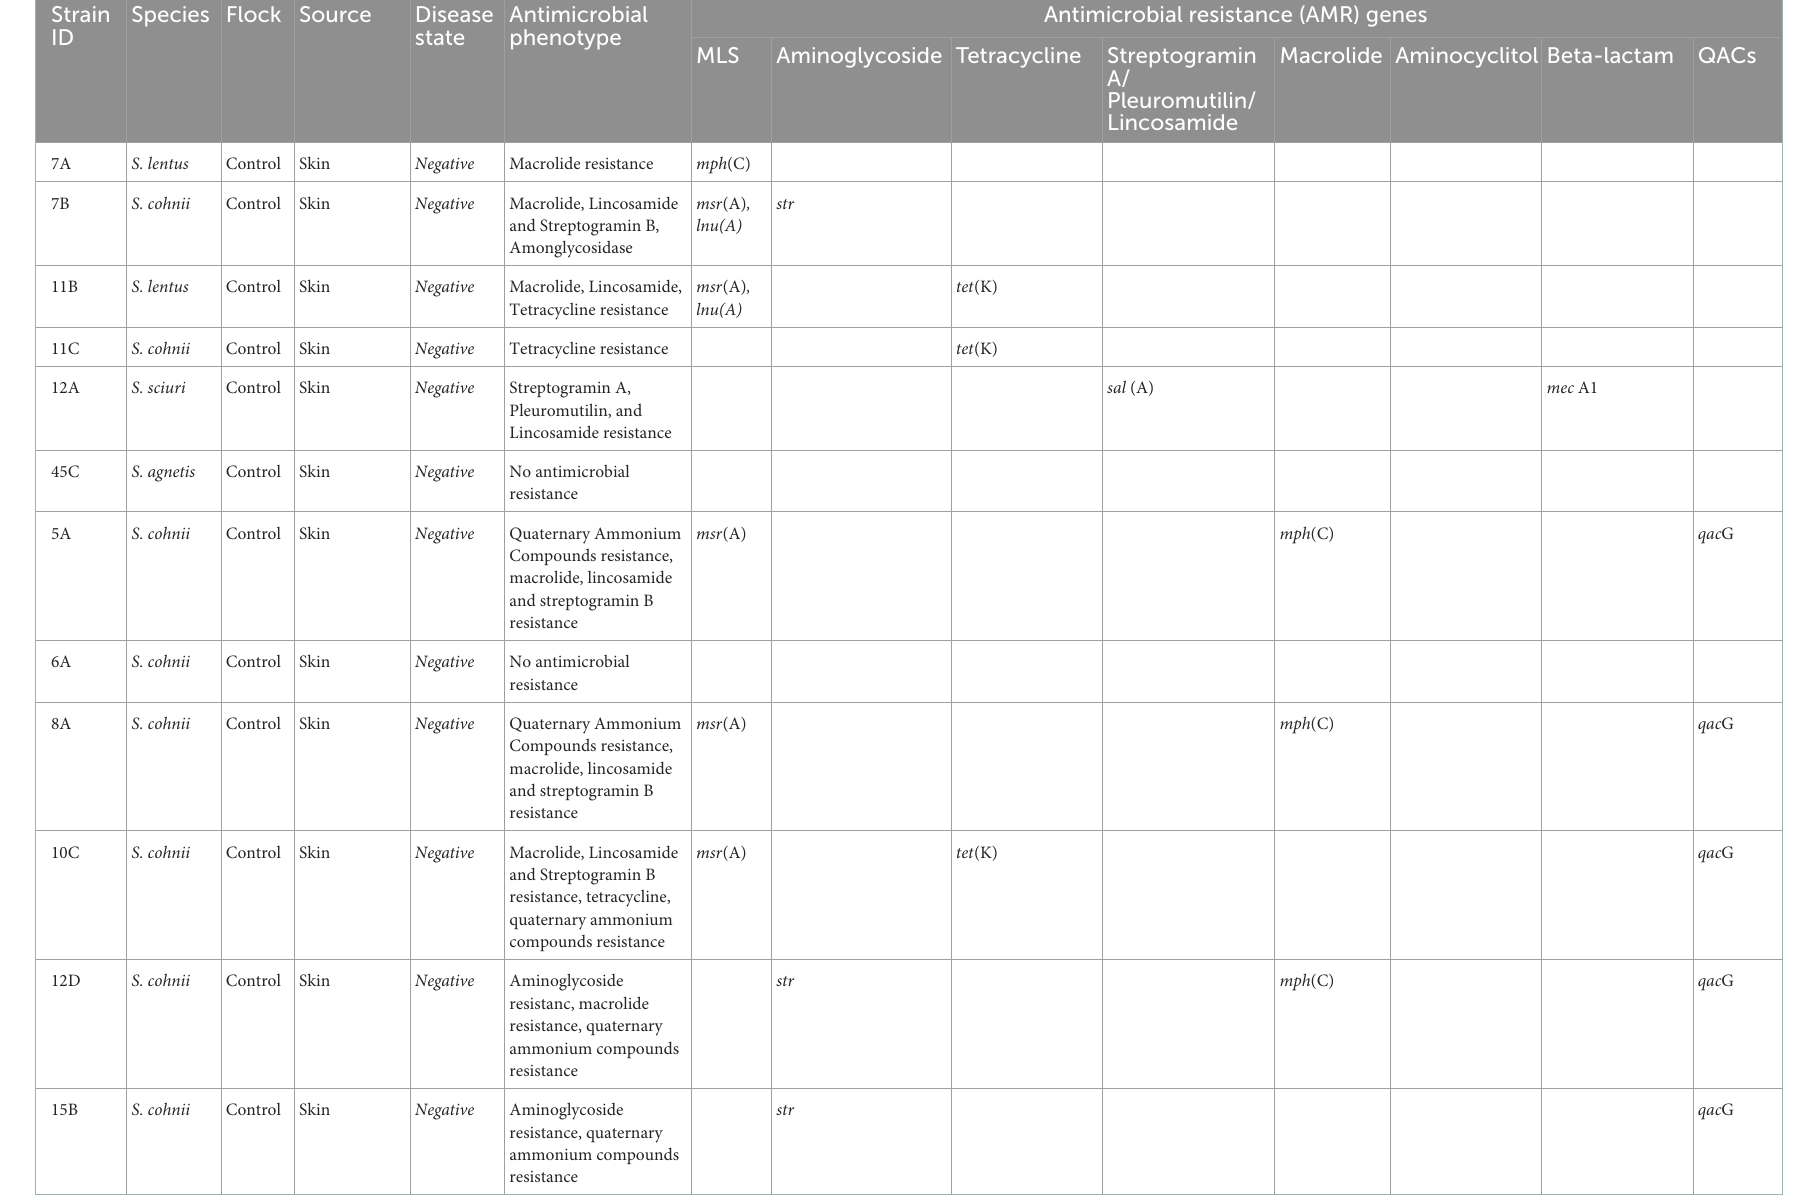
TABLE 3 Whole genome sequencing analysis of staphylococci isolates from control and FUDS affected flocks, bioinformatics analysis for identificantion of AMR